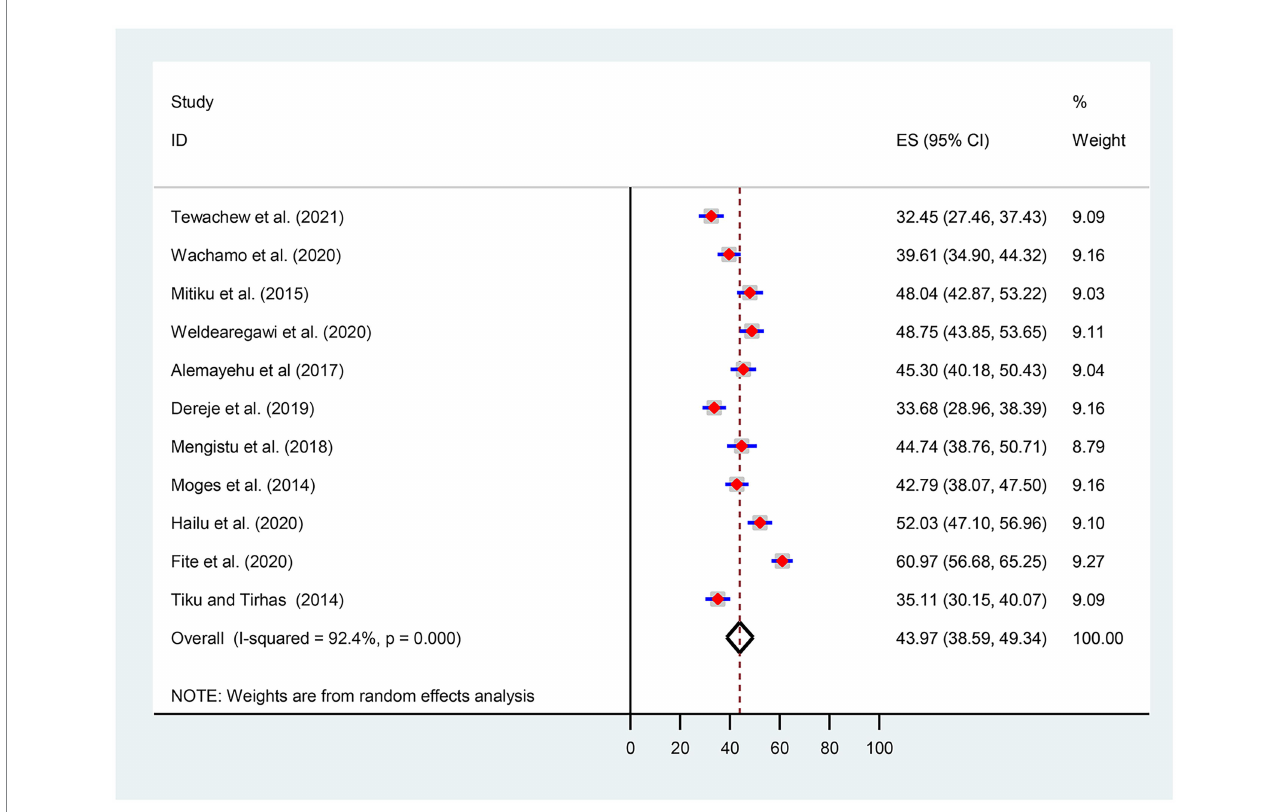
FIGURE 2 Forest plot for the pooled prevalence of opportunistic